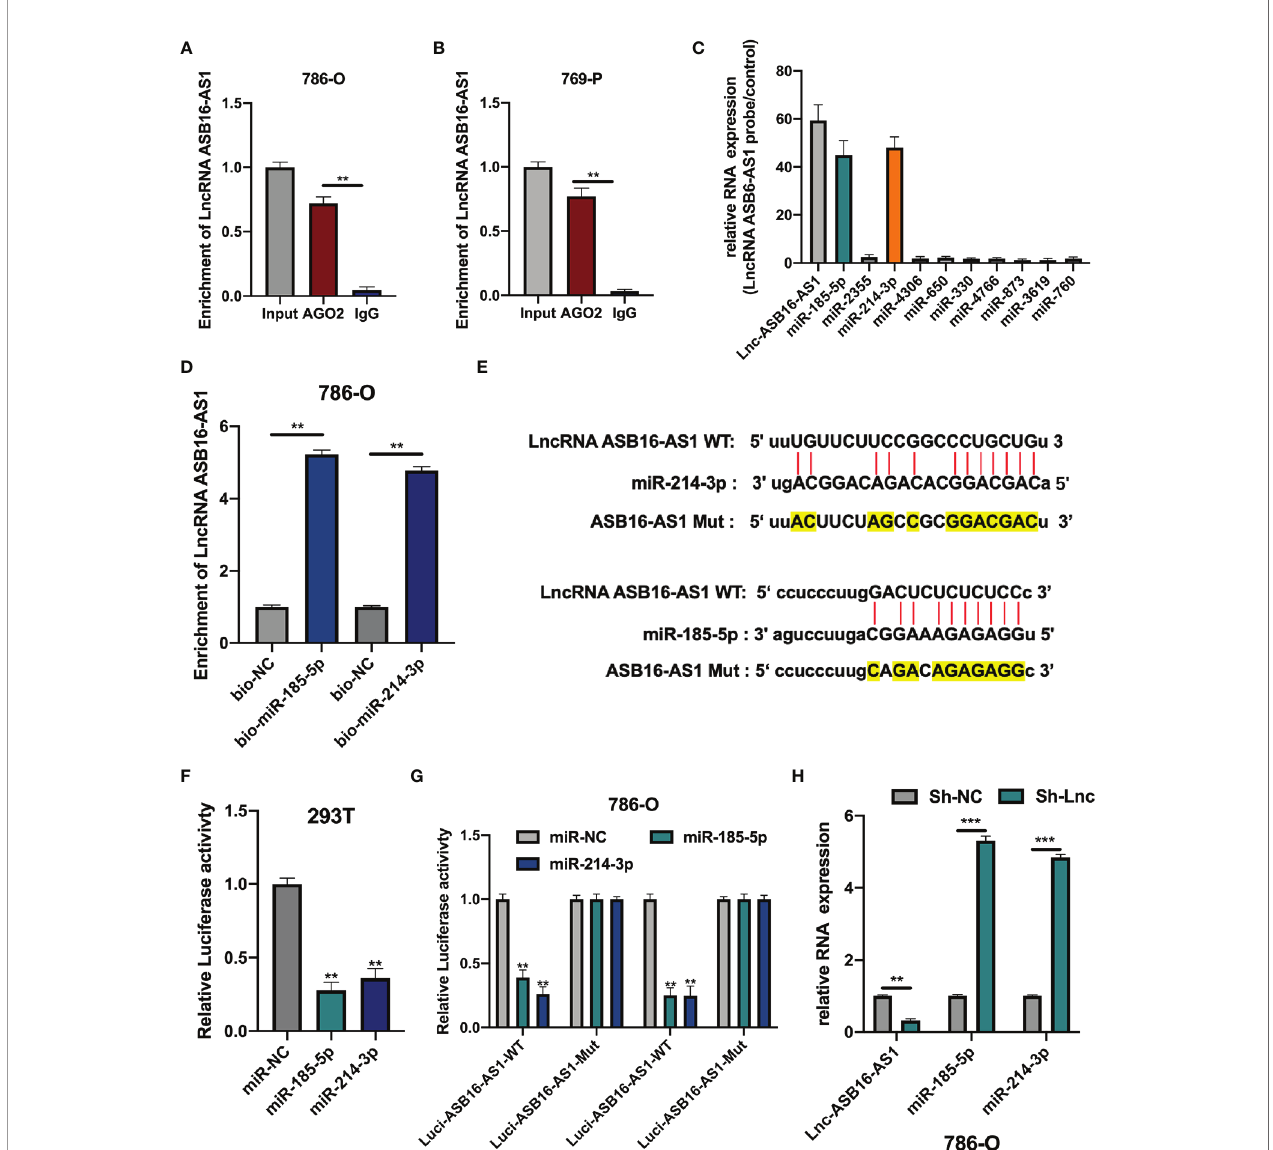
FIGURE 4 | ASB16-AS1 sponges miR-185-5p and miR-214-3p. (A, B) AGO2-RIP experiments were conducted to detect the potential miRNA binding ability of ASB16-AS1 by detecting the binding of ASB16-AS1 to the AGO2 protein in 786-O and 769-P cells, respectively. (C) The expression of potential miRNA targets in ASB16-AS1 probe RNA bound complexes (according to the number of supported AGO CLIP-seq experiments), measured by qRT-PCR and normalized to the control probe in 786-O cells. (D) Biotinylated RNA pull-downs were conducted to measure the enrichment of ASB16-AS1 in biotinylated miR-185-5p and miR-214-3p conditions. (E) Wild-type (WT) and mutated (MUT) sequences of the putative ASB16-AS1 miR binding sites aligned with miR-185-5p and miR-214-3p. Mutated bases are highlighted in yellow. (F, G) Luciferase reporter activity of Luc-ASB16-AS1-WT or MUT in 293T (F) and 786-O cells (G) after transfection with miR-185-5p and miR- 214-3p. (H) relative RNA expression in Sh-NC and Sh-ASB16-AS1 transfected 786-O cells, measured by qRT-PCR. All experiments were repeated at least three times. **P < 0.01, ***P <